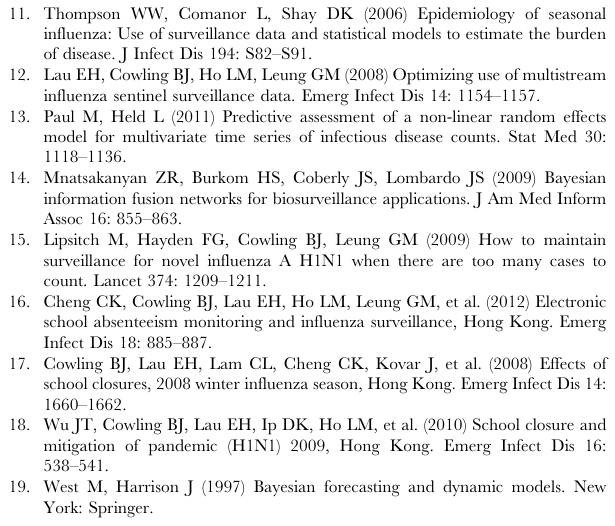
Table S2 Test of differences in correlations with changes in influenza activity, between surveillance data and inferred influenza level from the multivariate